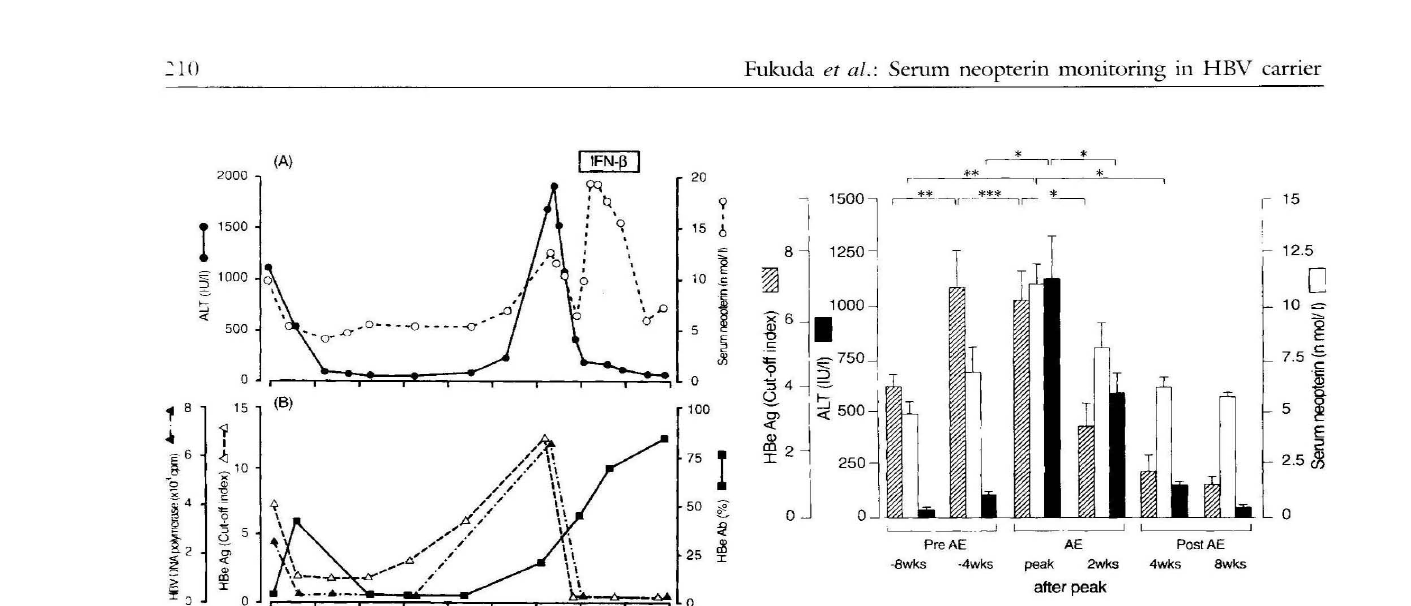
Figure 4. Temporal analysis of serum HBeAg, serum neopterin and ALT levels during the episodes of acute exacerbation (AE) of liver injury. The mean±SE for of serum HBeAg (cut-off index), serum neopterin levels (nmol/I) and ALT value (IUjl) before (8 weeks, 4 weeks), during (peak, two weeks after peak), and after (4 weeks, 8 weeks) AE are shown. The dynamics of HBV replication, immunoactivation and liver injury was demonstrated during the period of AE. *P<O.Ol; **P<0.05; ***Not